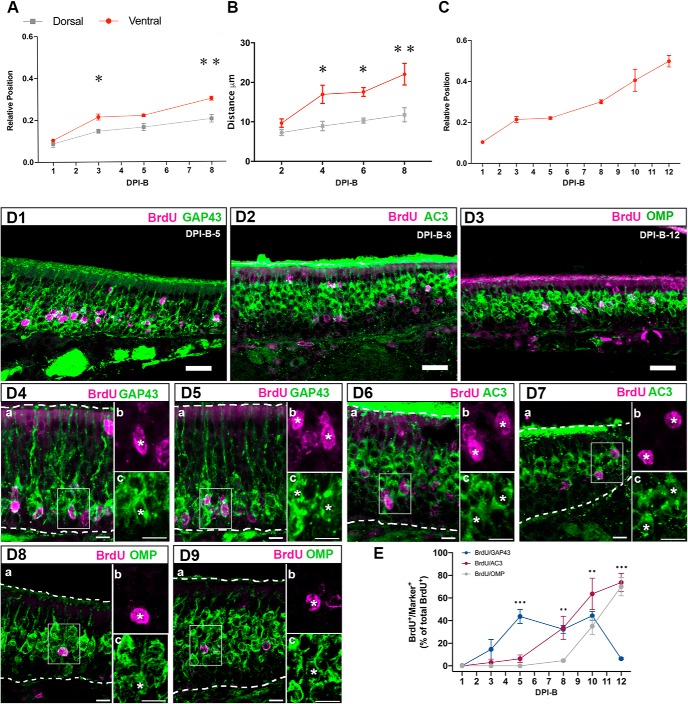
Migration and maturation of P25-born OSNs in the septal OE. A, Newborn OSNs migrate radially in the OE. Graph showing relative radial position of BrdU+ cells in the dorsal (gray) and ventral (red) septal OE at different time points after BrdU injections. B, Graph showing the distance between BrdU+ cells and the basal lamina; distance is represented in micrometers. C, Relative position of P25-born OSNs in the ventral zone of the septum at six different time points during a 12 d timecourse after BrdU administration. The mean ± SEM values are plotted (n = 3). *p < 0.05, **p < 0.01. D, Coimmunolabeling for BrdU (magenta) and markers of maturation (green): GAP 43, AC3, and OMP at different time points after BrdU administration. D1–D3, Confocal images at low magnification representing flattened stacks of 10–12 1-μm-thick optical sections. D4–D9, High-magnification confocal images representing flattened stacks of seven to nine 1-μm-thick optical sections. GAP 43 and BrdU costaining at DPI-B-5 (D4, D5). AC3 and BrdU costaining at DPI-B-8 (D6, D7). OMP and BrdU costaining at DPI-B-12 (D8, D9). In D4a–c to D9a–c, square cells (a) are magnified in b showing BrdU labeling, and in c showing the corresponding markers GAP 43, AC3, and OMP. In both b and c, colabeled cells are marked with an asterisk. E, Line graph showing the percentage of colabeled (marker/BrdU) cells of the total number of BrdU+ cells counted. Transition from immature to mature OSN occurs at 10 d after basal cell division. OSNs first express AC3 at 5 d post-basal cell division. OMP expression is not evident until 8 d post-basal cell division. The mean ± SEM values are plotted (n = 3). **p < 0.01, ***p < 0.001. Dashed white lines delineate the surface of the OE (top) and basal lamina (bottom). DRAQ-5 is in blue. Scale bars: D1–D3, 25 μm; D4–D9, 10 μm.